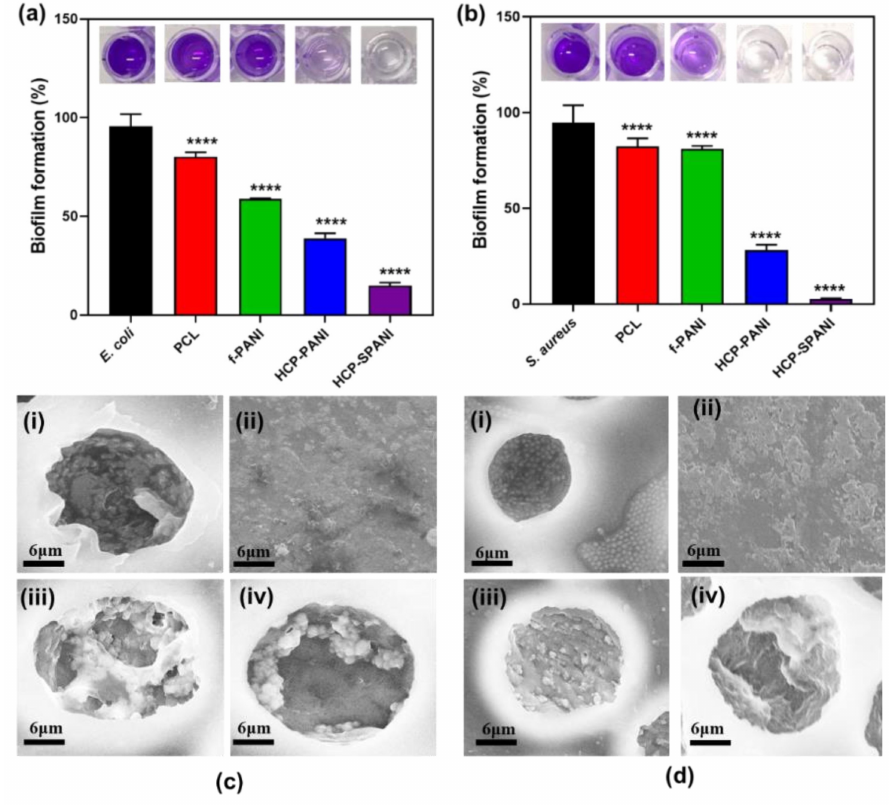
Figure 9. Antibiofilm activity of the fabricated films against ( a ) E. coli and ( b ) S. aureus after 24 h of biofilm growth measured at OD (570 nm) . The data are averages of three independent experiments performed in triplicate, **** p < 0.0001. SEM images of ( i ) PCL, ( ii ) f-PANI, ( iii ) HCP-PANI, and ( iv ) HCP-SPANI films after 24 h of biofilm assay against ( c ) E. coli and ( d ) S. aureus